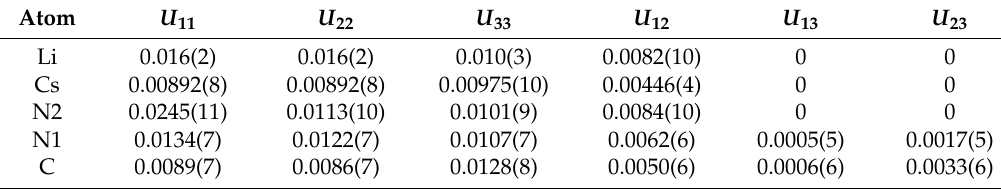
Table 5. Anisotropic displacement parameters U ij (Å 2 ) of LiCs 2 [dca] 3